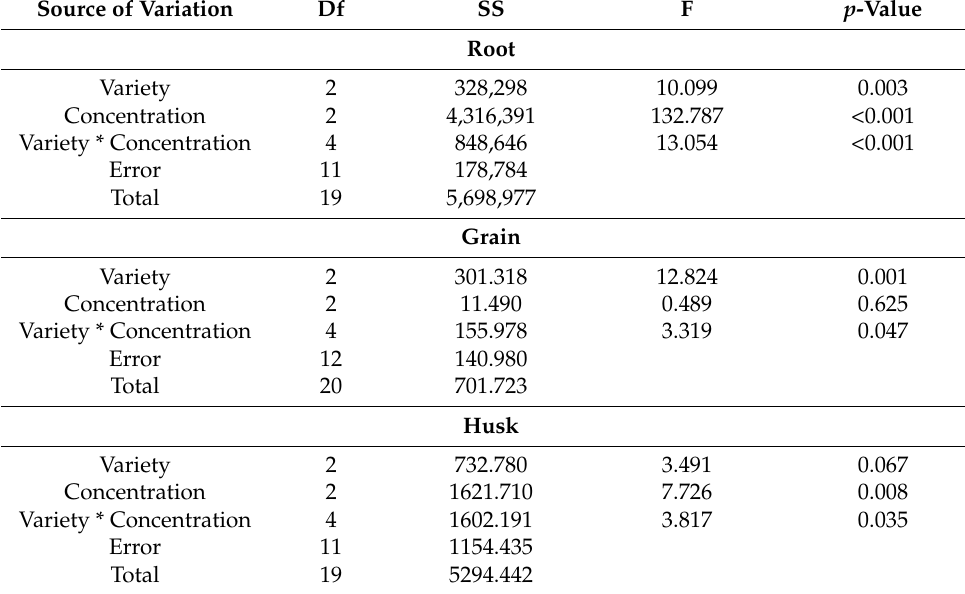
Table 2. Factorial ANOVA for the Hg concentration in the roots, grains, and husks of the commercial varieties of Oryza sativa L. grown in soils containing different Hg levels ( α = 0.05). Source of Variation Df SS F p -Value Root Variety 2 328,298 10.099 0.003 Concentration 2 4,316,391 132.787 <0.001 Variety * Concentration 4 848,646 13.054 <0.001 Error 11